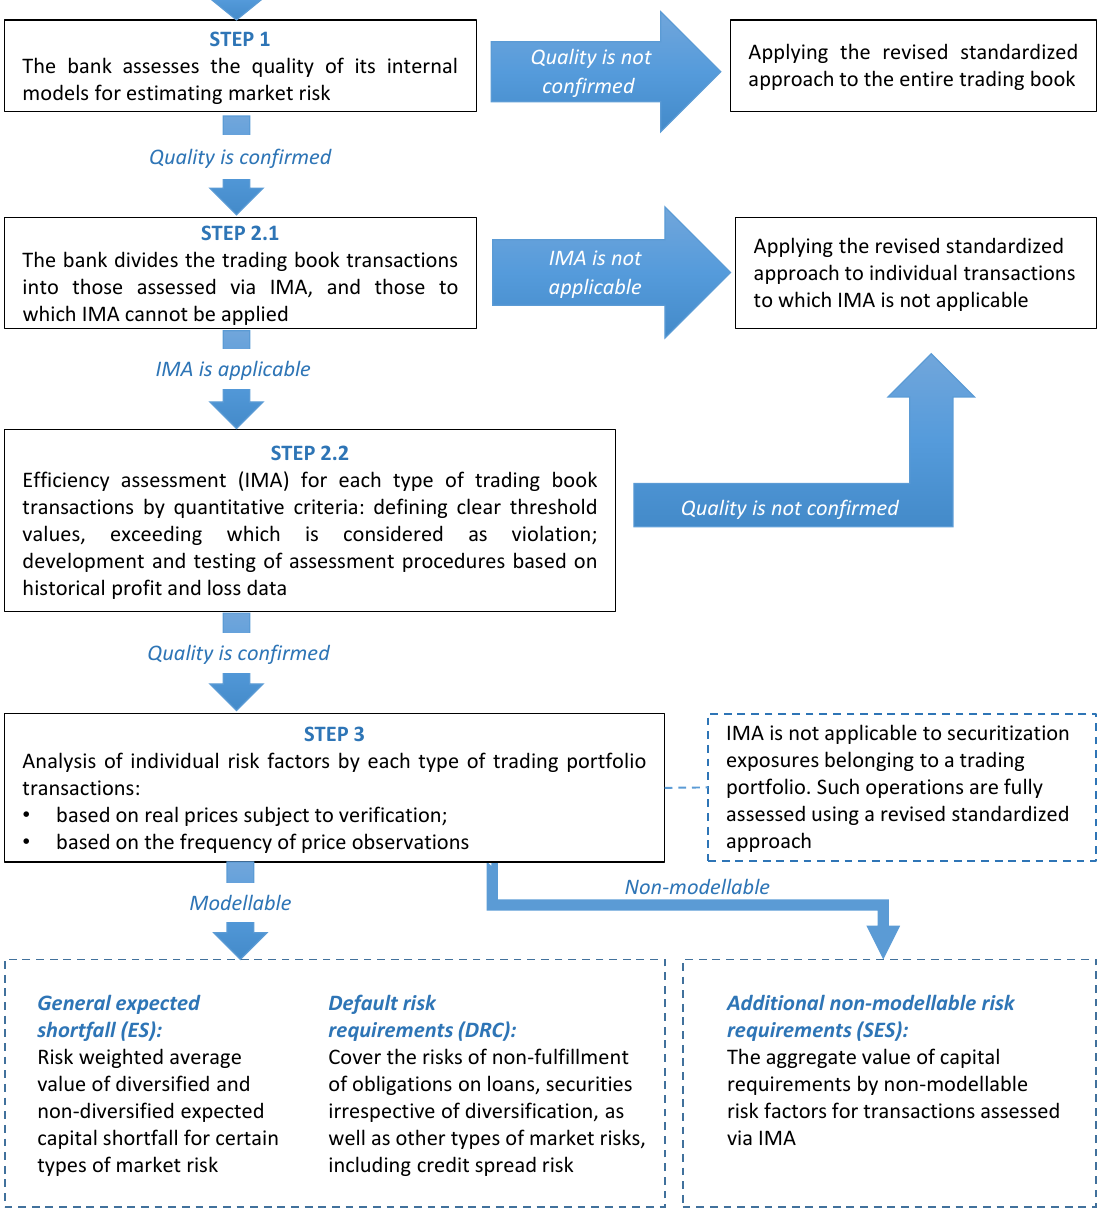
Figure 2. Assessment of capital requirements using the internal models